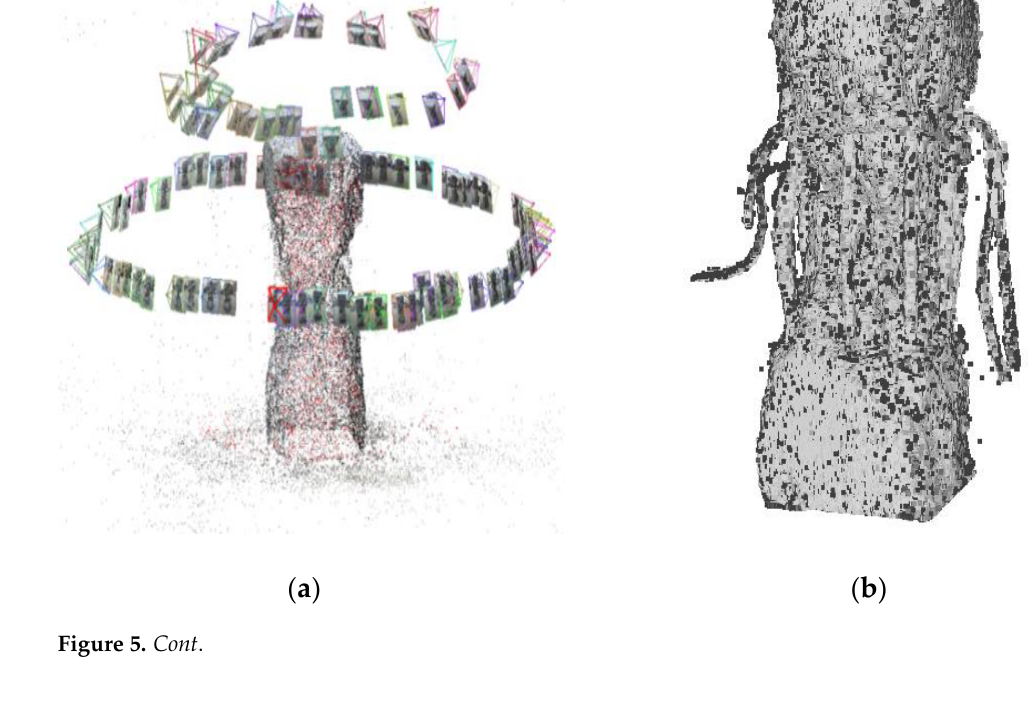
( d ) Figure 5. Images from each step of the 3D reconstruction process. ( a ) Sparse point cloud image; ( b ) dense point cloud image; ( c ) Poisson surface reconstruction image; ( d ) texture-mapped image.